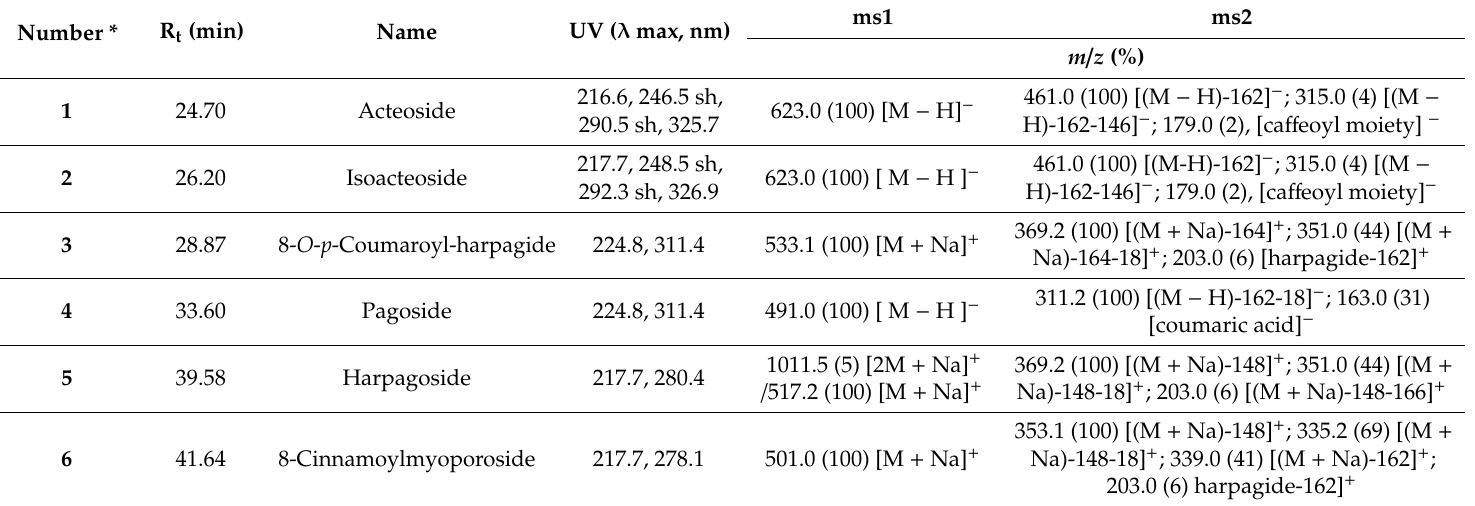
Table 1. MS fragmentation and UV-VIS absorption data of compounds detected in the tinctures of Harpagophytum procumbens by HPLC-DAD (270